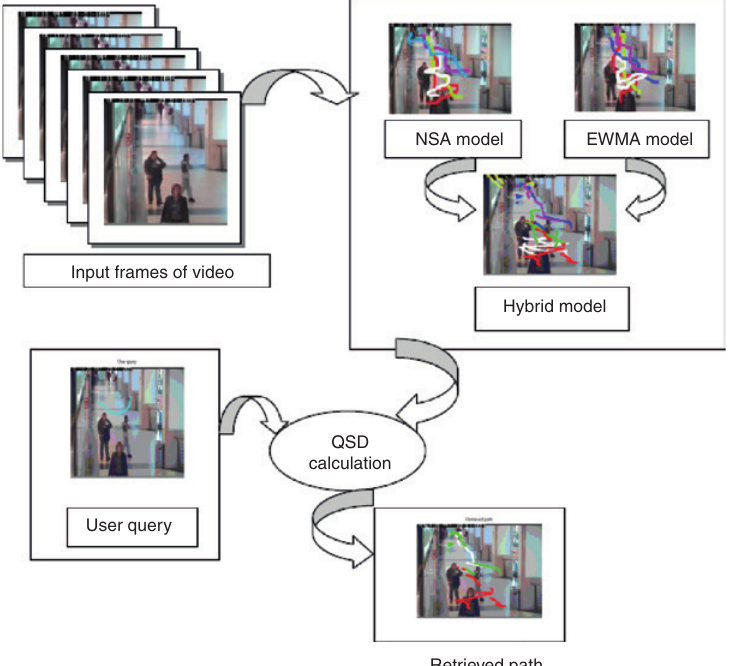
Figure 1: Block Diagram Representation of the Proposed Video Object Retrieval Methodology.